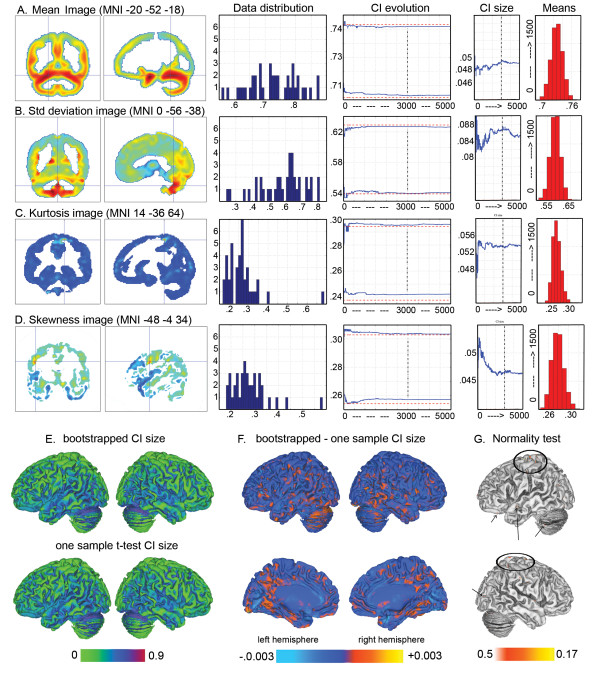
Illustration of the advantage and robustness of the bootstrap procedure over the one-sample t-test confidence interval. From A to D, histograms of the grey matter values across subjects are plotted for the maximum of the average image, the standard deviation image, the kurtosis image and the skewness image. As illustrated (data distribution in blue), data did not conform well (bias) to the normal distribution. This resulted in an over-estimation of the CI size using a one sample t-test (red dotted lines on the CI evolution graphics). By contrast, bootstrapped CI sizes were narrower (blue lines on the CI evolution graphics). This is illustrated over the whole brain on brain renders E and F. Overall, bootstrapped and t-test CI were similarly distributed (E) but bootstrapped CI were in general narrower (warm colours in F). The average one-sample t-test CI size was 0.0486 ± 0.0096 (min 0.0198, max 0.096, median 0.0474) vs. 0.0461 ± 0.0091 (min 0.0188, max 0.0895, median 0.045) for the 5000 resamples bootstrap CIs. This difference was statistically significant (t(251572) = 65.25 p < .00001), illustrating the advantage of the bootstrap approach, even if the majority of brain voxels have a close to Normal distributions (G – Lilliefors test > .05 – arrows and circles indicates the few 'non-normal' voxels). Graphics titled 'CI size' illustrate the evolution of the bootstrapped CI size with the number of resamples. The vertical dotted line mark the 3000th resample, from which CI size tend to be stable. On the right hand side, graphics titled 'Means' show the distribution of the data means after 5000 resample (to compare with the original 'data distribution') from which the last bootstrapped CIs were obtained.